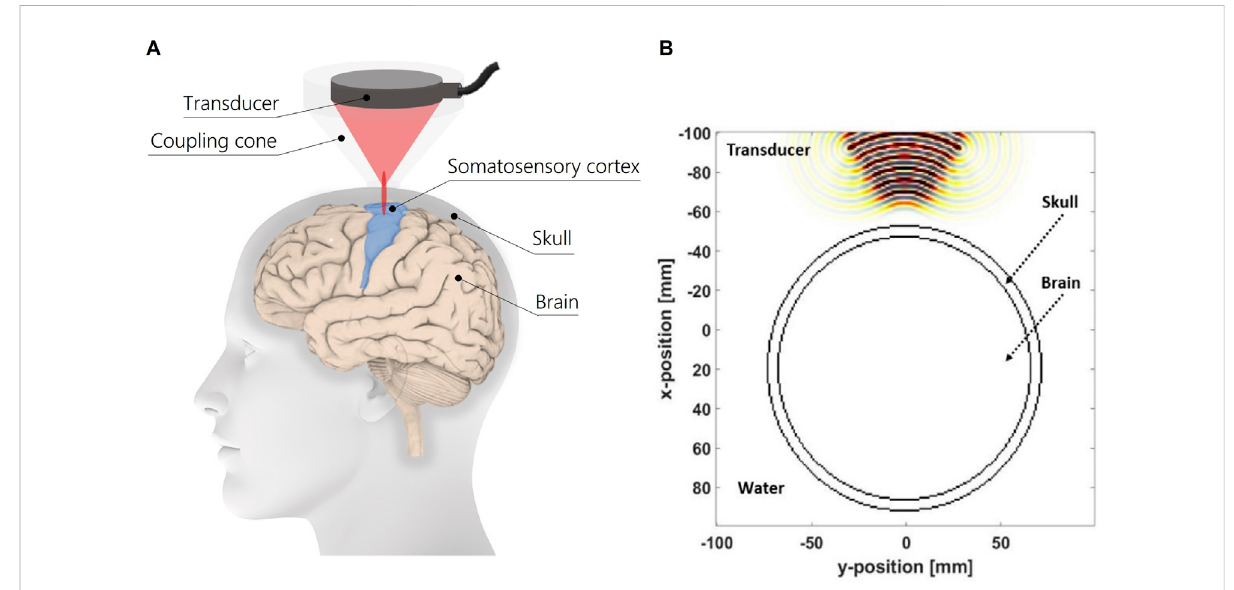
FIGURE 2 (A) Schematics of the tFUS setup, (B) geometry of the 2D simpli fi ed human head model.